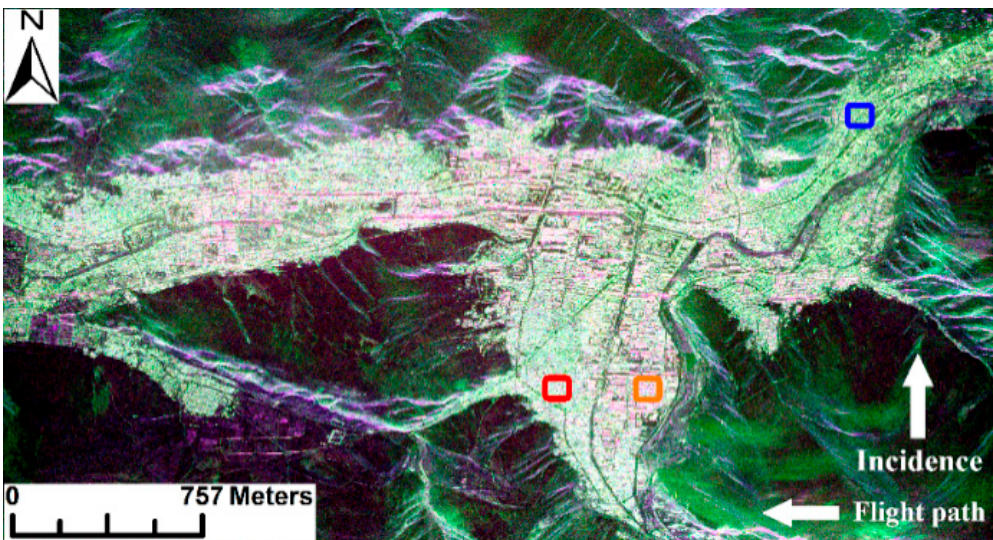
Figure 10. The Pauli RGB pseudocolor image for the full-polarimetric SAR data of Yushu County urban region. The areas in the red, blue, and orange rectangles are the samples of CB, OB, and parallel buildings (PB), respectively.